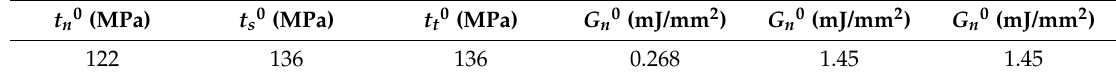
Table 3. Strengths and fracture toughness of cohesive